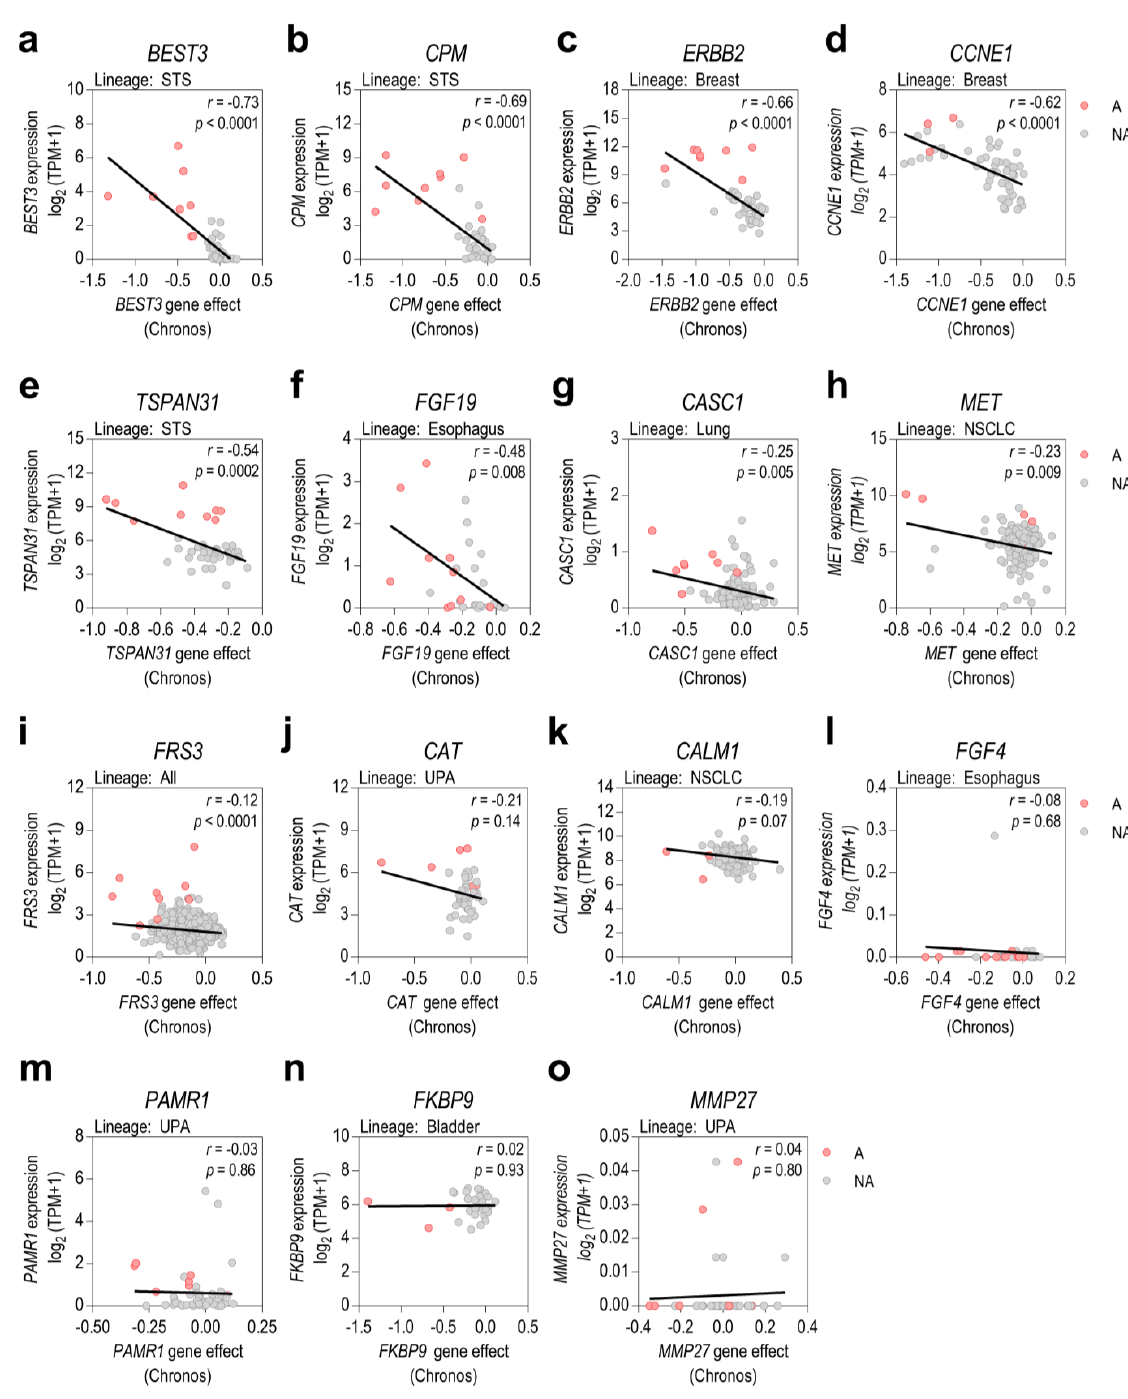
Figure 4. Assessment of gene expression as a predictive biomarker of gene dependency. ( a – o ) Pearson’s correlations between relative gene expression and gene knockout effects are shown for prioritized genes in cell lines from selected lineages. Cell lines were also classified into amplified (A, red dots) and non-amplified (NA, grey dots). STS: soft-tissue sarcoma; NSCLC: non-small cell lung cancer; UPA: upper aerodigestive tumors.